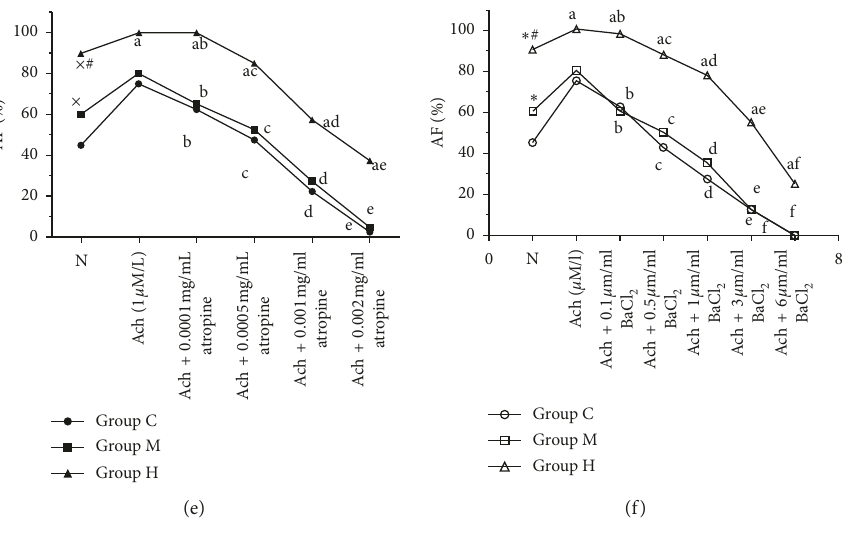
Figure 3: (a) Comparison of atrial APD90 in rabbits with different-intensity continuous training under different Ach + atropine concentrations; (b) comparison of atrial APD90 in rabbits with different-intensity continuous training under different Ach + barium chloride concentrations; (c) comparison of atrial AERP(ms) in rabbits with different-intensity continuous training under different Ach + atropine concentrations; (d) comparison of atrial AERP(ms) in rabbits with different-intensity continuous training under different Ach + barium chloride concentrations. Compared with Groups C and M, d